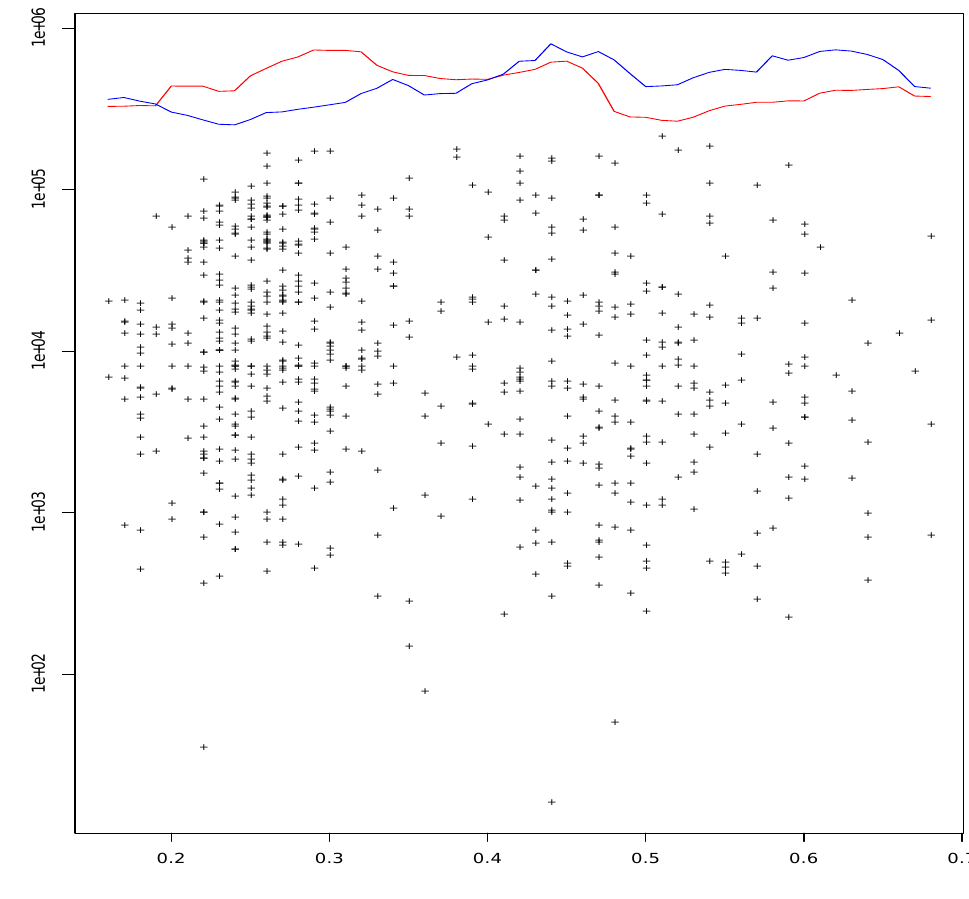
Figure 6: Illustration on motorcycle insurance data. Horizontally: Age of the policyholder (hundred of years), vertically: Claim severity (SEK, log scale). Data ( + ), nonparametric conditional Weissman estimator ˇ q extreme quantile estimator ˜ q